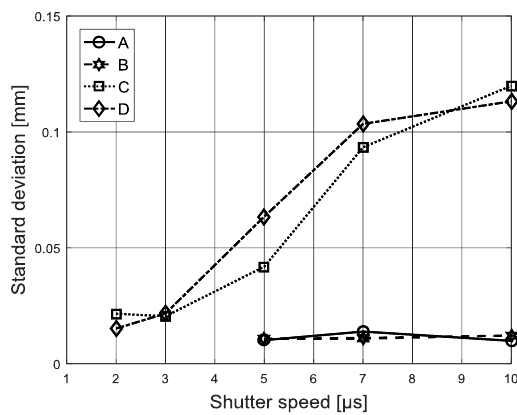
Fig. 11. Normal distribution – standard deviation – effect of shutter